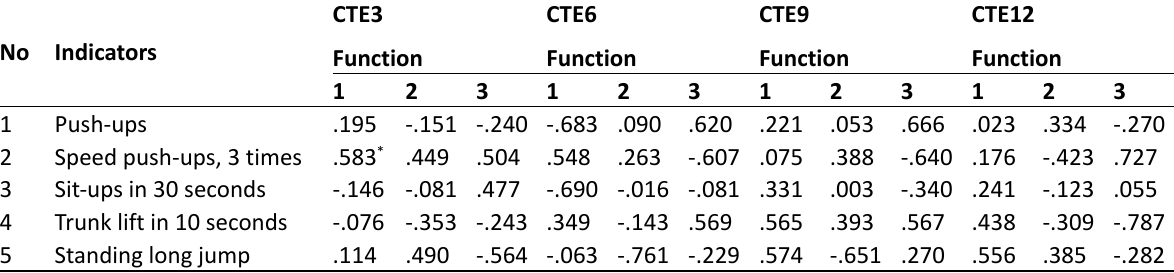
Table 5. Structure matrix. Boys aged